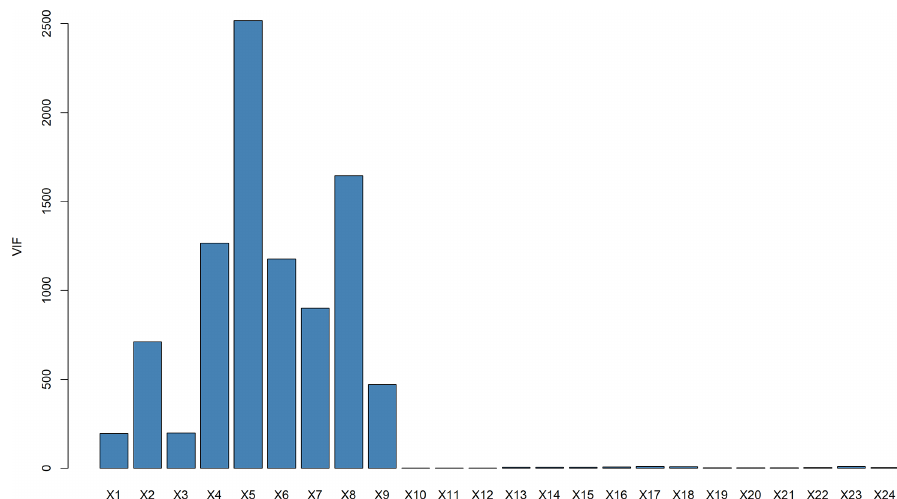
Figure 9. Variance inflation factor (VIF) values of all predictor’s variables in 3 months of observational data.